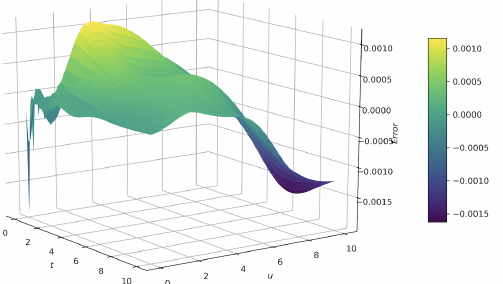
Figure 5. The error between DNN approximation for parameter 1 and the explicit solution.